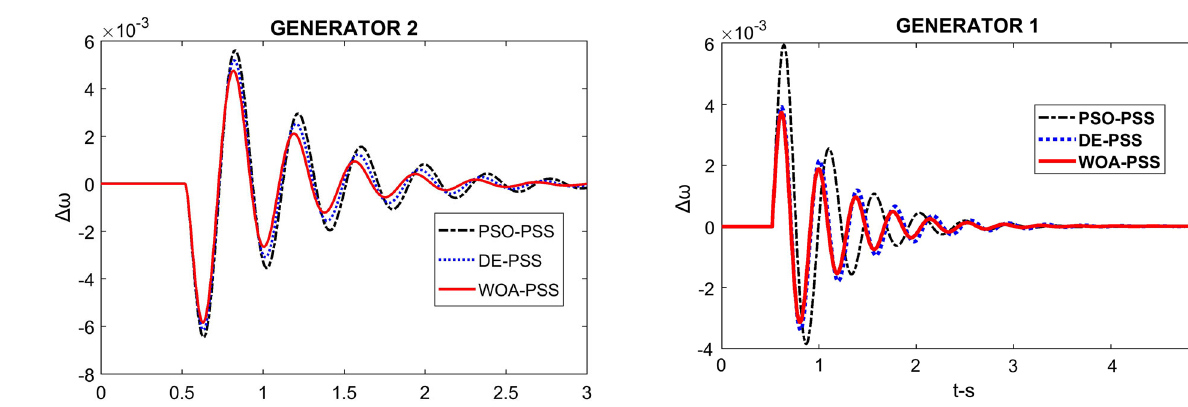
Fig. 10 Speed deviation of G1 for 10% step change at